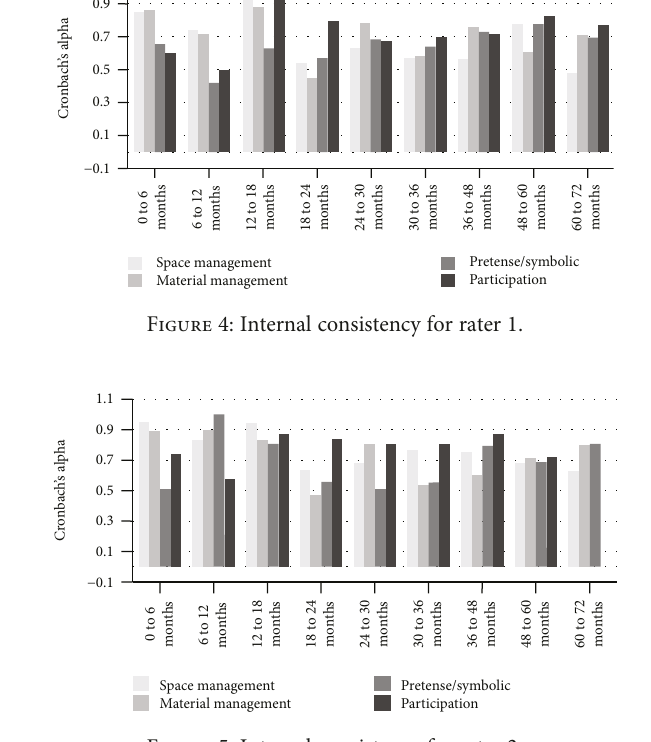
Figure 5: Internal consistency for rater